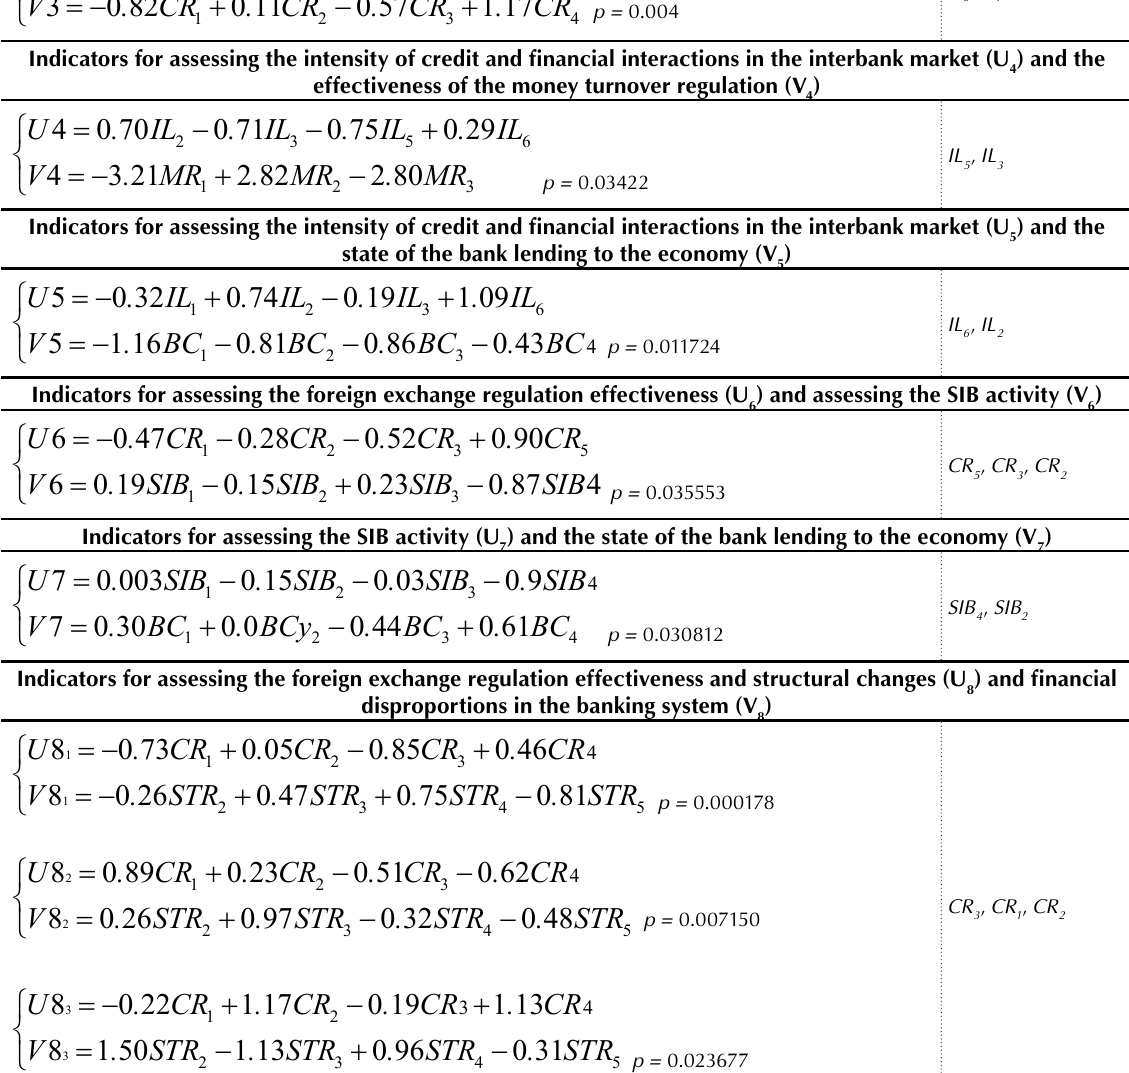
Indicators for assessing the foreign exchange regulation effectiveness (U